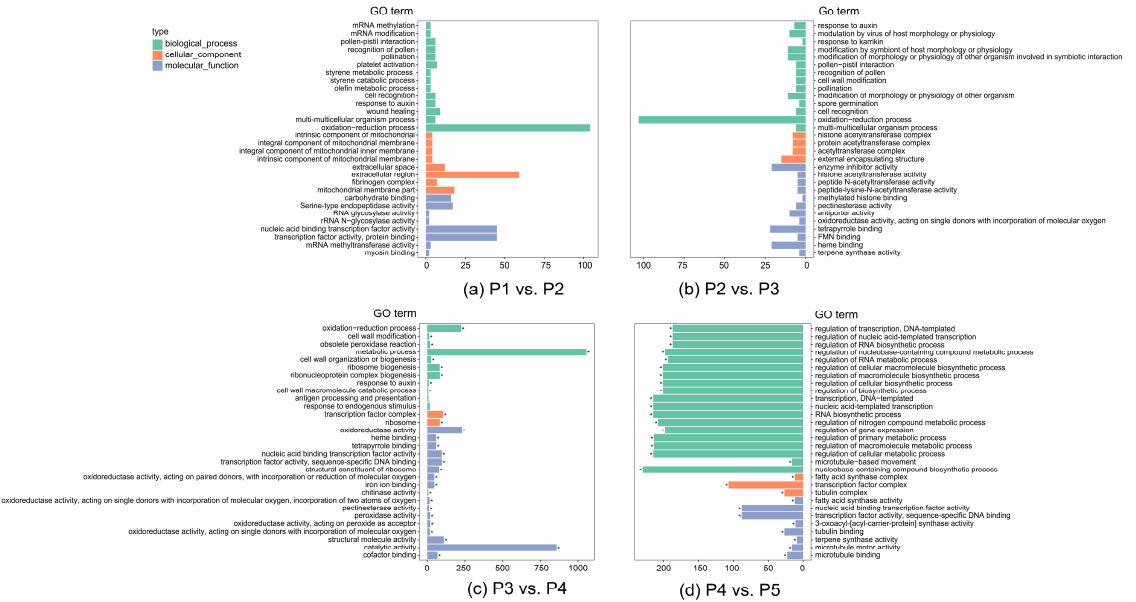
Figure 3. GO enrichment of DEGs in different comparisons. ( a – d ) the comparison of P1 vs. P2, P2 vs. P3, P3 vs. P4, and P4 vs. P5. P1 − P3: 1 − 3-year-old bulbs that cannot flower, P4 − P5: 4-year-old nonflowering and flowering bulbs. The vertical axis is the names of the GO terms; the horizontal axis is the numbers of genes enriched in each term. The three GO term types are shown in different colors. Asterisks represent significant